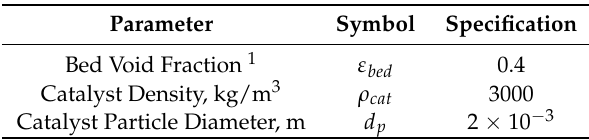
Table 1. Ammonia synthesis reactor